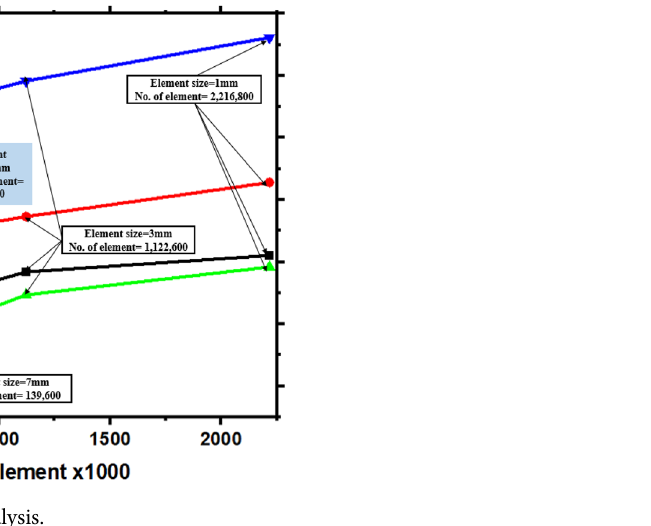
Figure 4. Mesh convergence